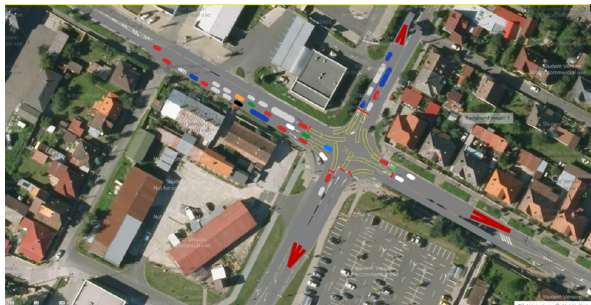
Figure 11: Traflc situation at the 1st modified intersection model